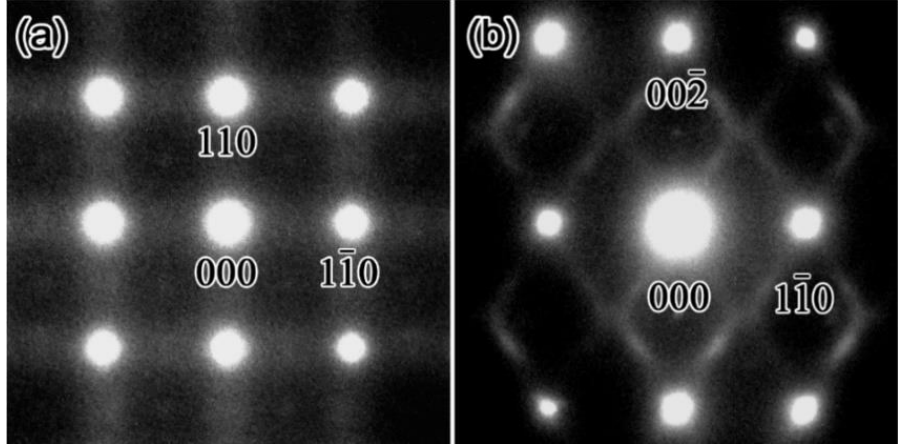
Figure 8. Diffraction patterns of Zr-18 at.%Nb alloy. The zone axis is [001] in ( a ) and [110] in ( b ).